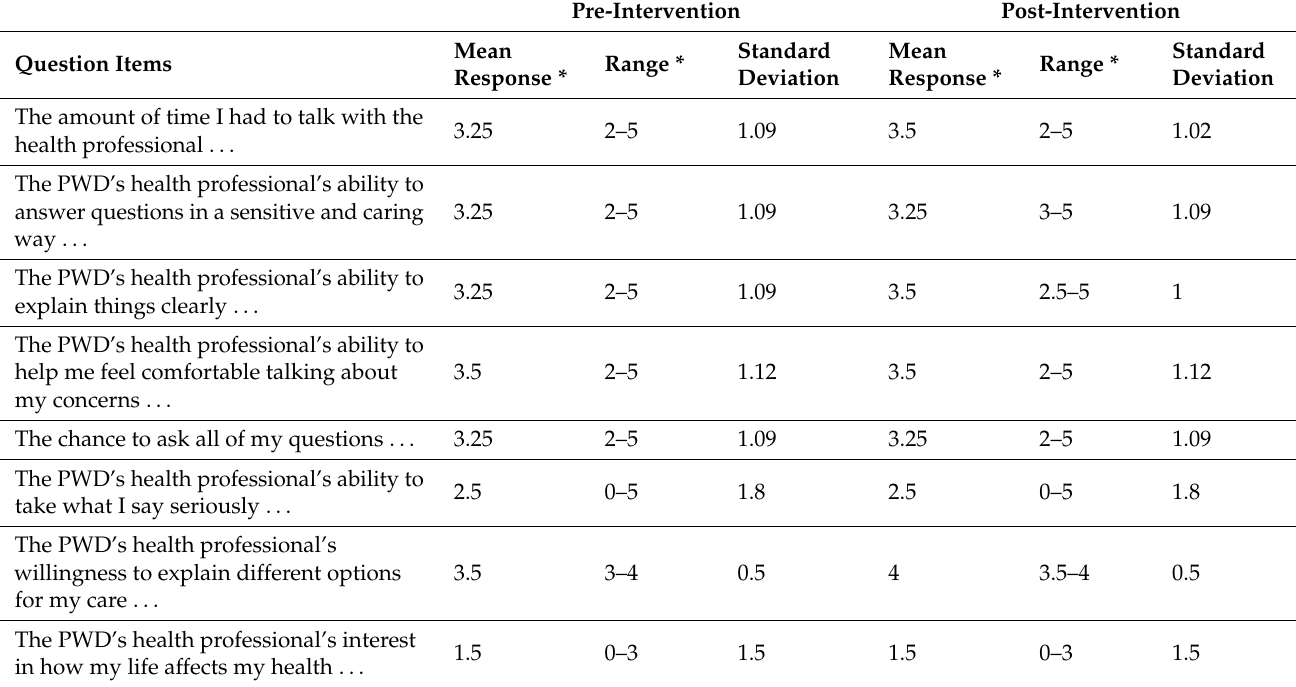
Table 3. Satisfaction scale results regarding family physician pre- and post-intervention. Pre-Intervention